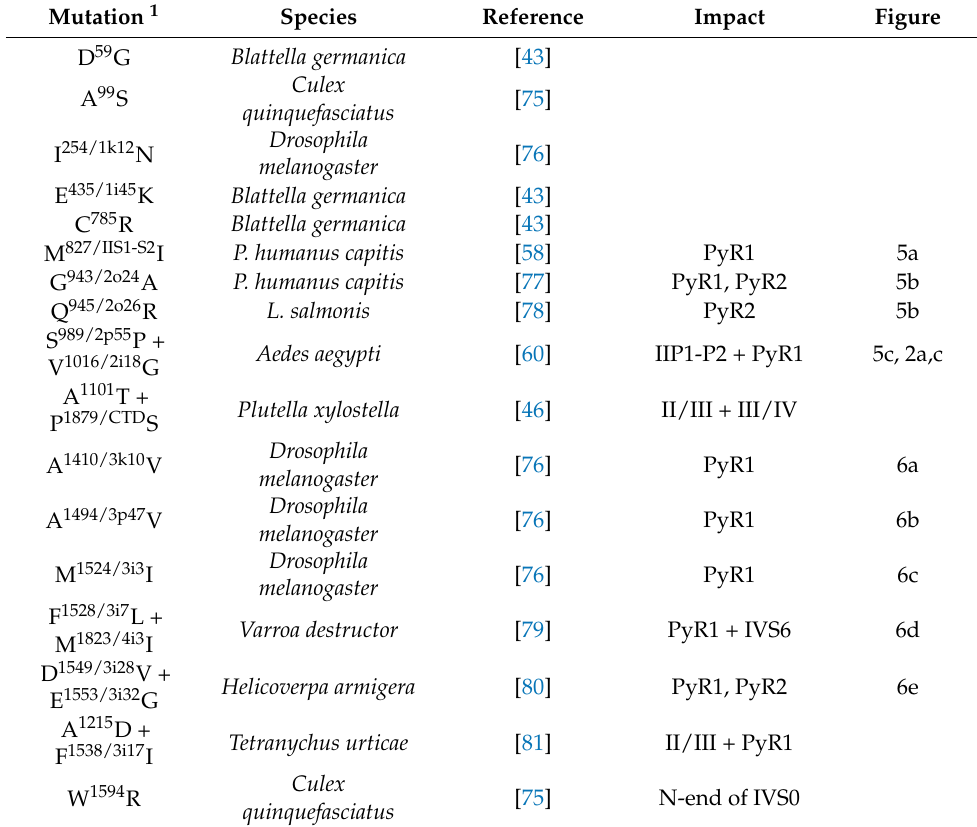
Table 3. Kdr Mutations beyond the PyR1 and PyR2